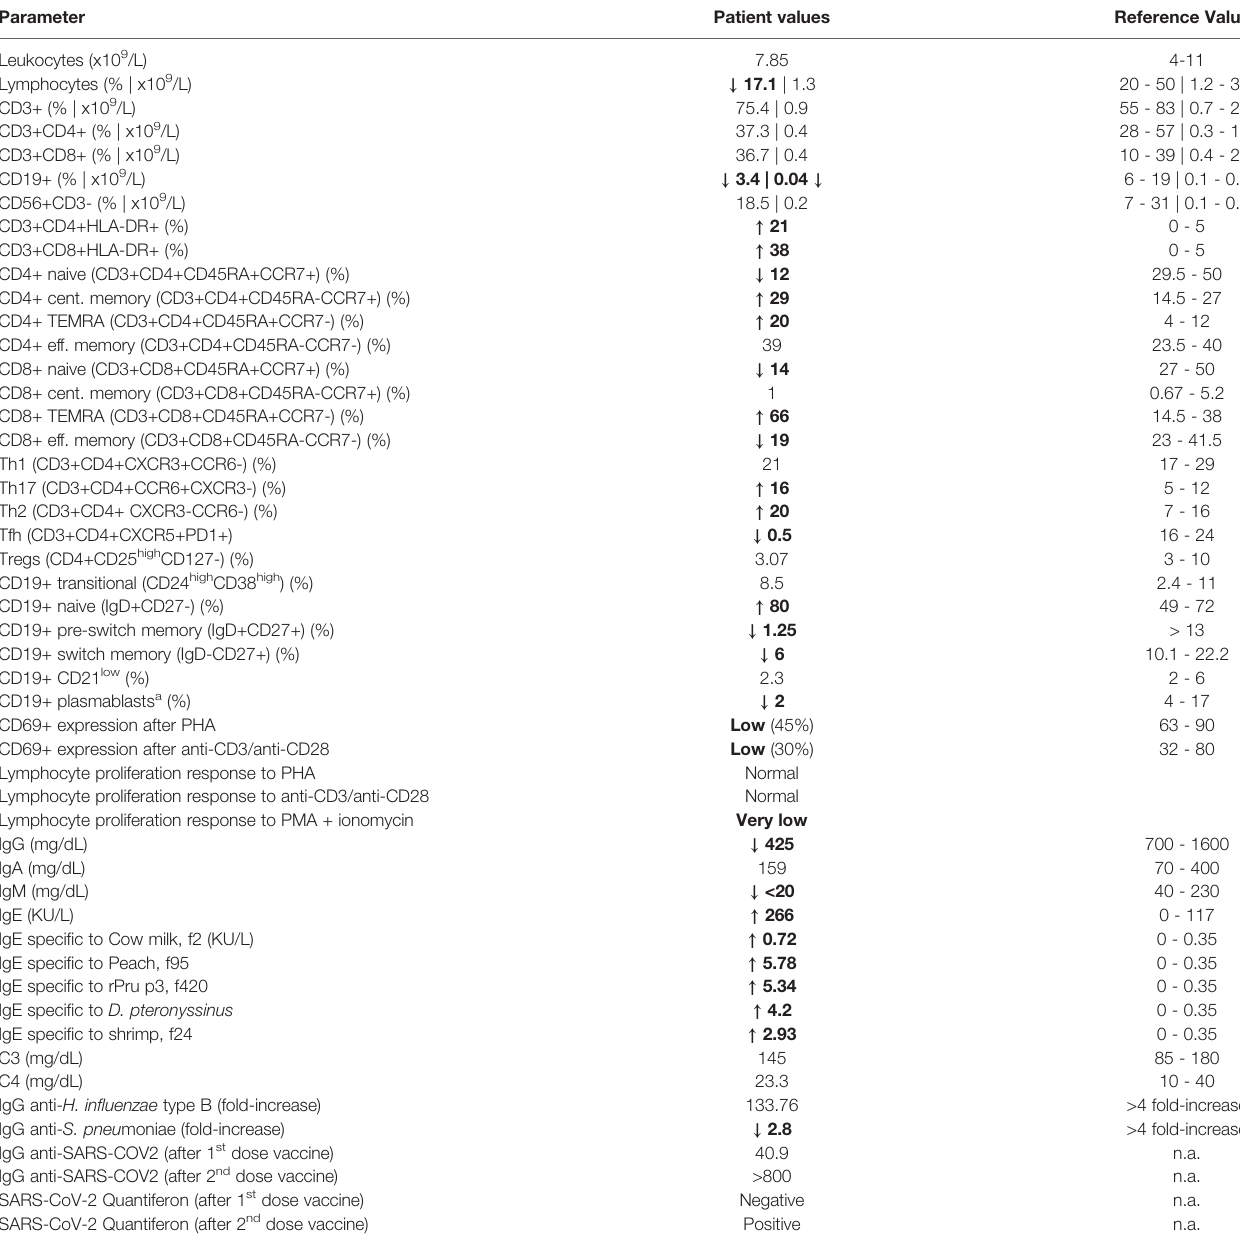
TABLE 1 | Immunological parameters of SASH3-de fi cient